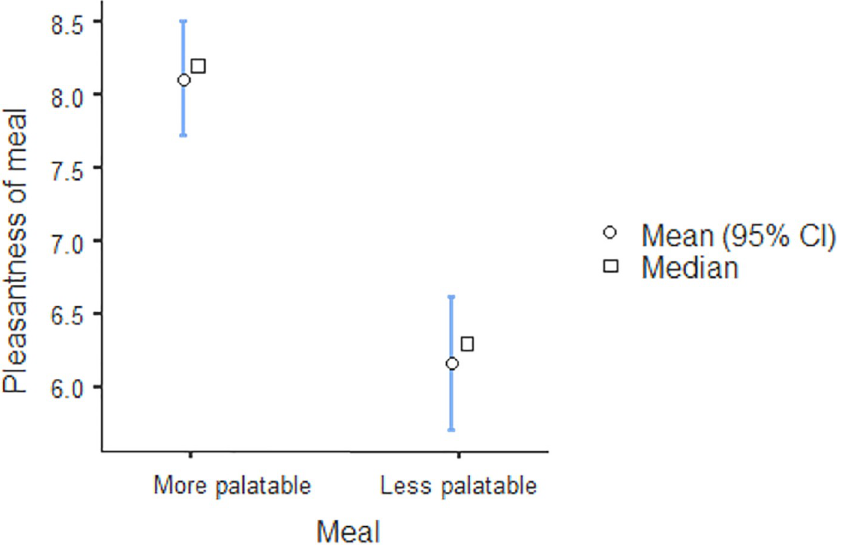
Fig 2. Pleasantness of meals according to experimental